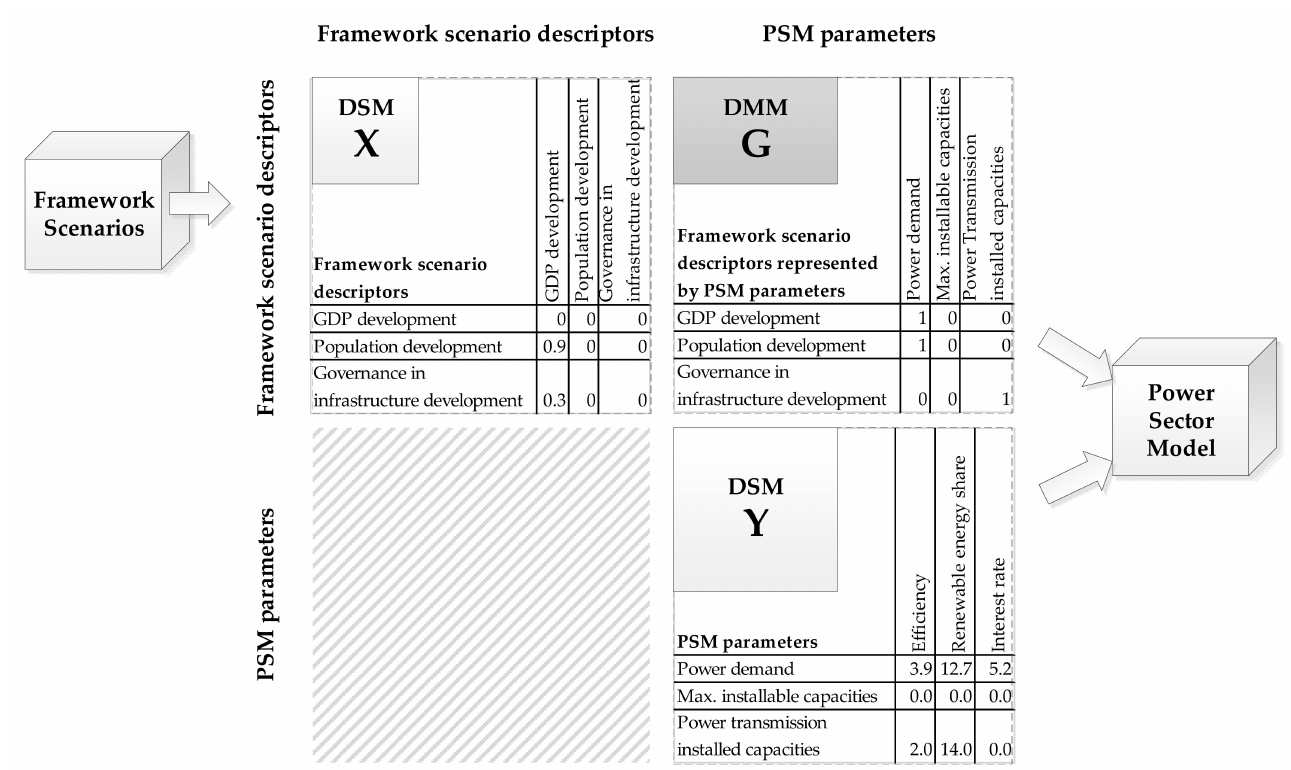
Figure 3. Schematic representation of a multiple-domain matrix, including: (a) design structure matrices (DSMs), X and Y, for domain intradependencies; and (b) a domain-mapping matrix (DMM), G, for domain interdependencies. The two domains represented are: (1) the descriptor domain, linked to the framework scenarios; and (2) the PSM-input-parameter domain, linked to the power-sector model. Descriptor intradependencies are recorded in X on the basis of the information provided by experts for the creation of the framework scenarios. In Matrix G, descriptors represented by PSM parameters are identified by the power-sector modellers. Matrix Y is obtained from the matrix multiplication of X and G (see Section 2.2). The information provided in G and Y is used for the base-scenario selection and for the parametrisation of the power-sector model. Examples of the types of entries recorded in the different matrices are shown